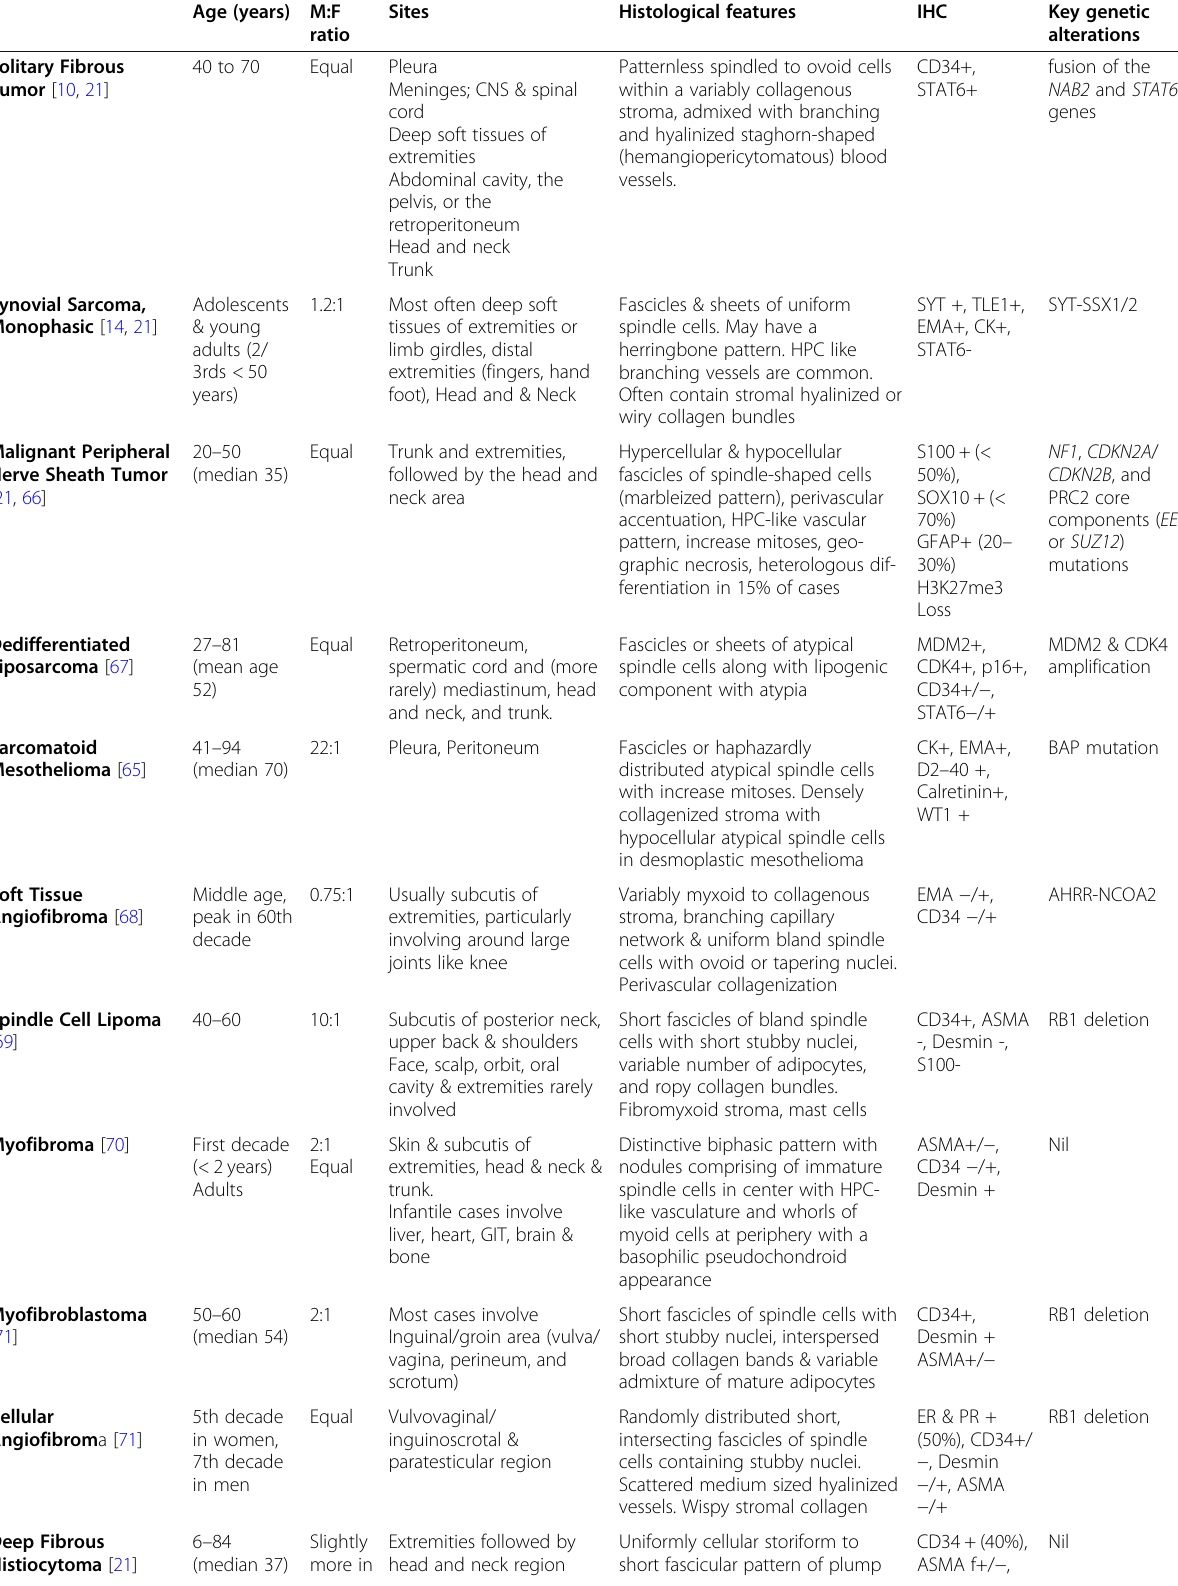
Table 1 Differential Diagnosis of Solitary Fibrous